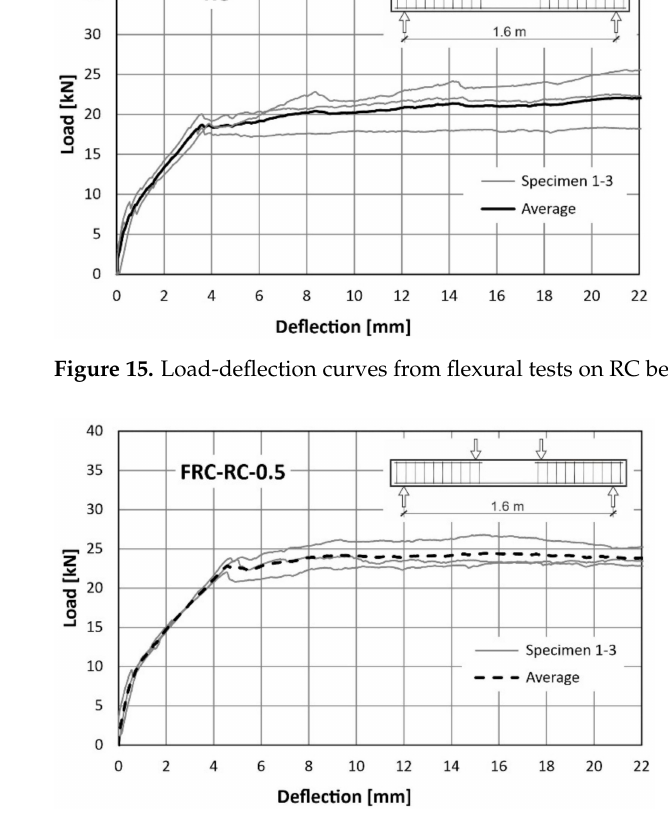
Figure 16. Load-deflection curves from flexural tests on FRC-RC-0.5.